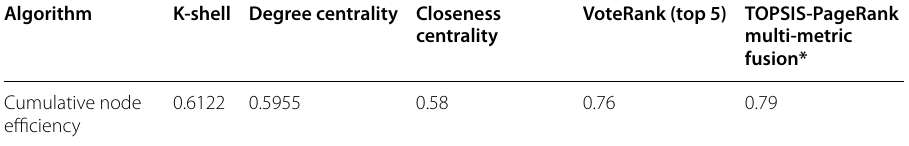
Table 5 Cumulative node efficiency